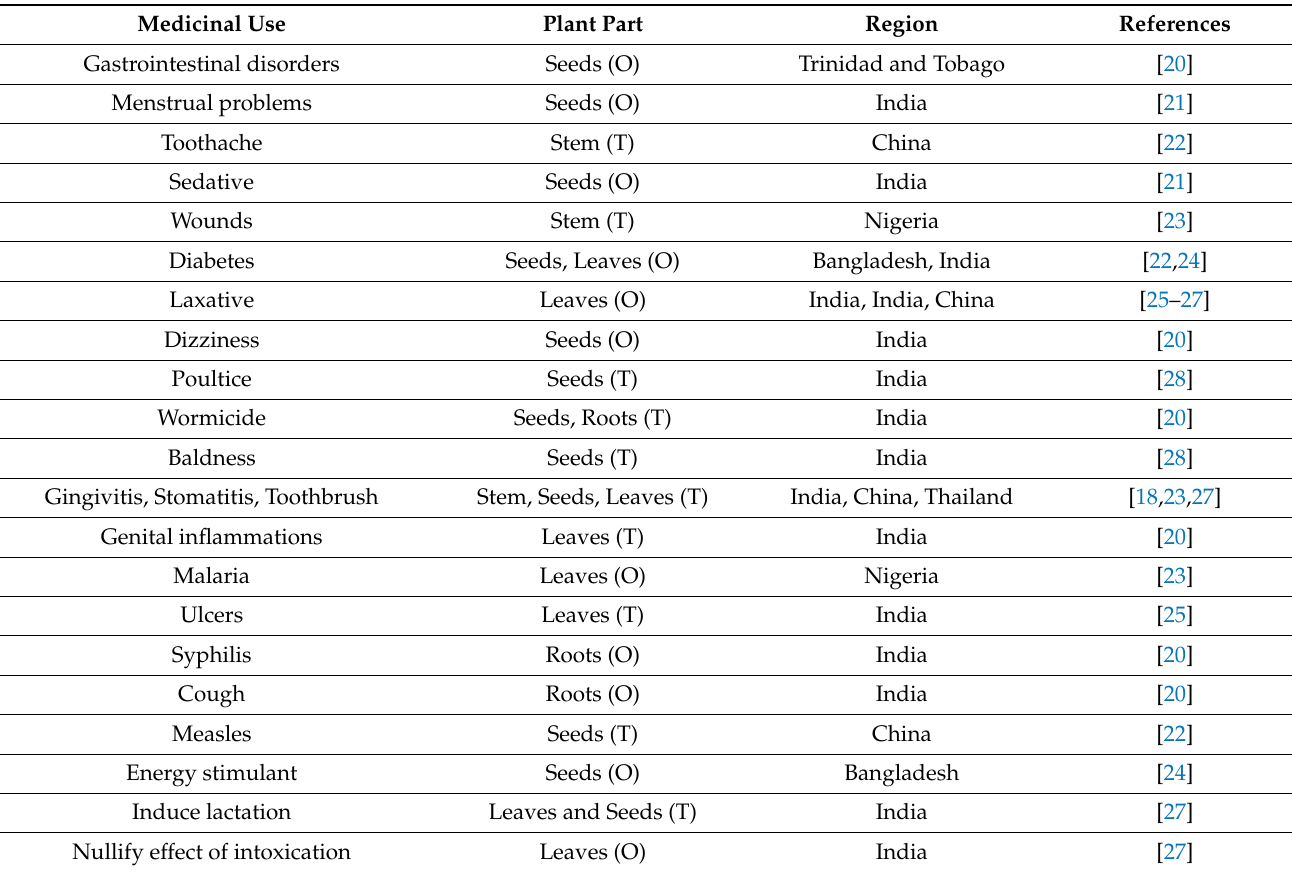
Table 1. Ethnomedicinal uses of Cajanus cajan from different regions.